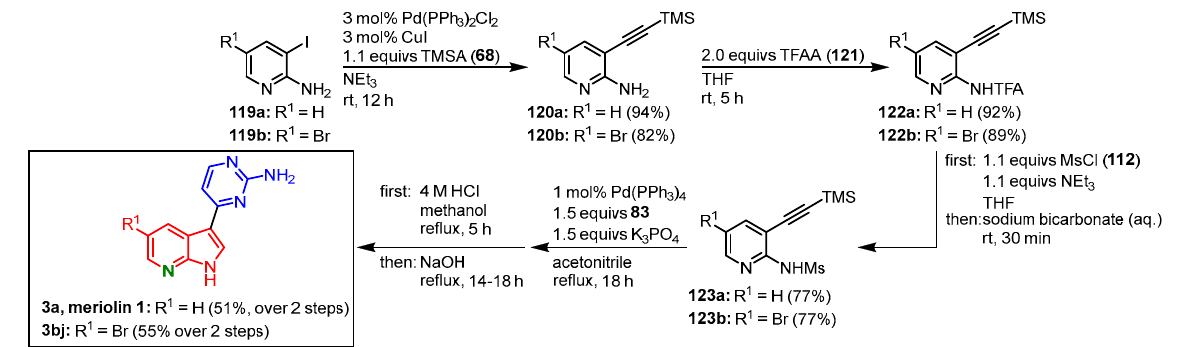
Figure 33. Synthesis of meriolins 3a and 3bj via domino amino-palladation reaction by Morris [67].